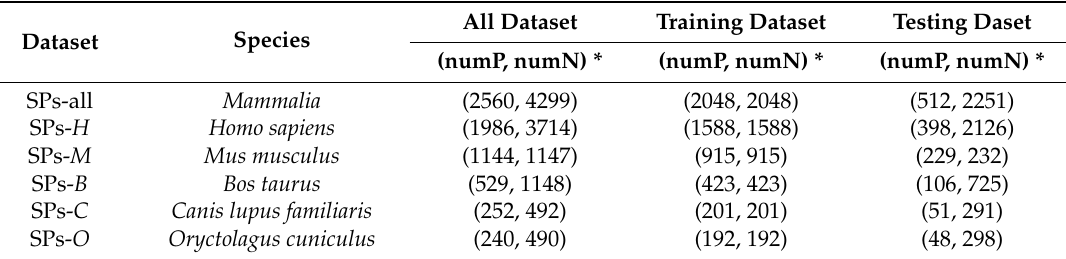
Table 7. A breakdown of newly-compiled datasets used in this